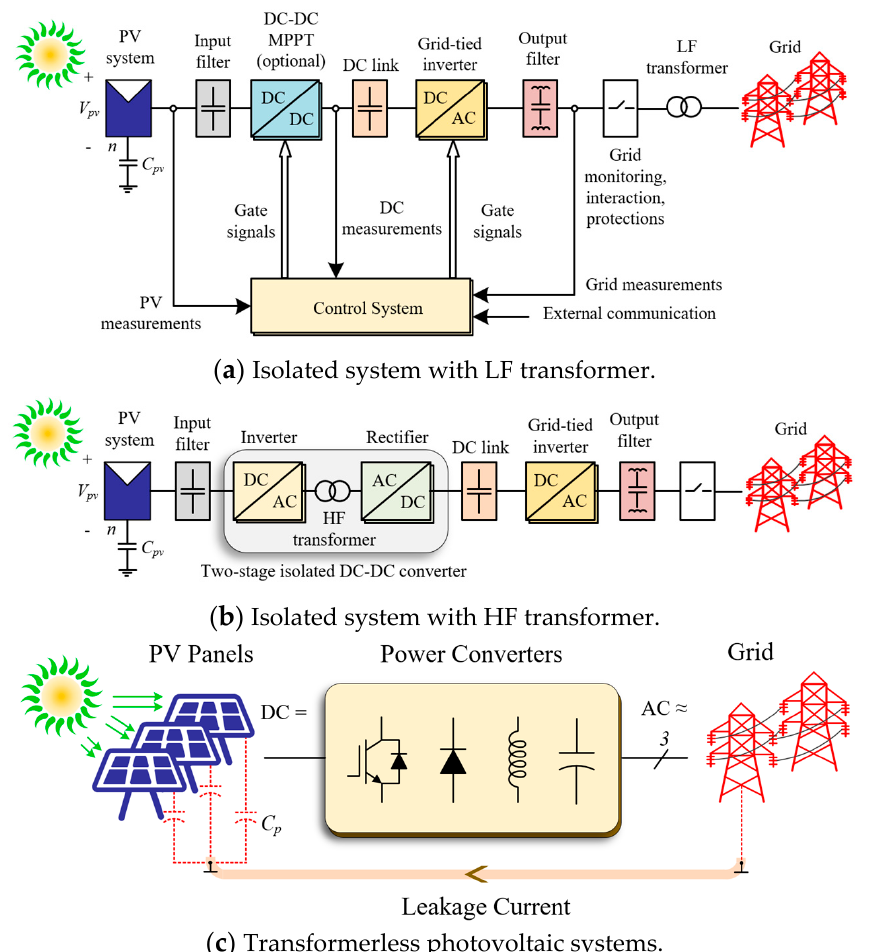
Figure 4. Schematic diagram of isolated and non-isolated grid-connected PV energy conversion sys- tems.